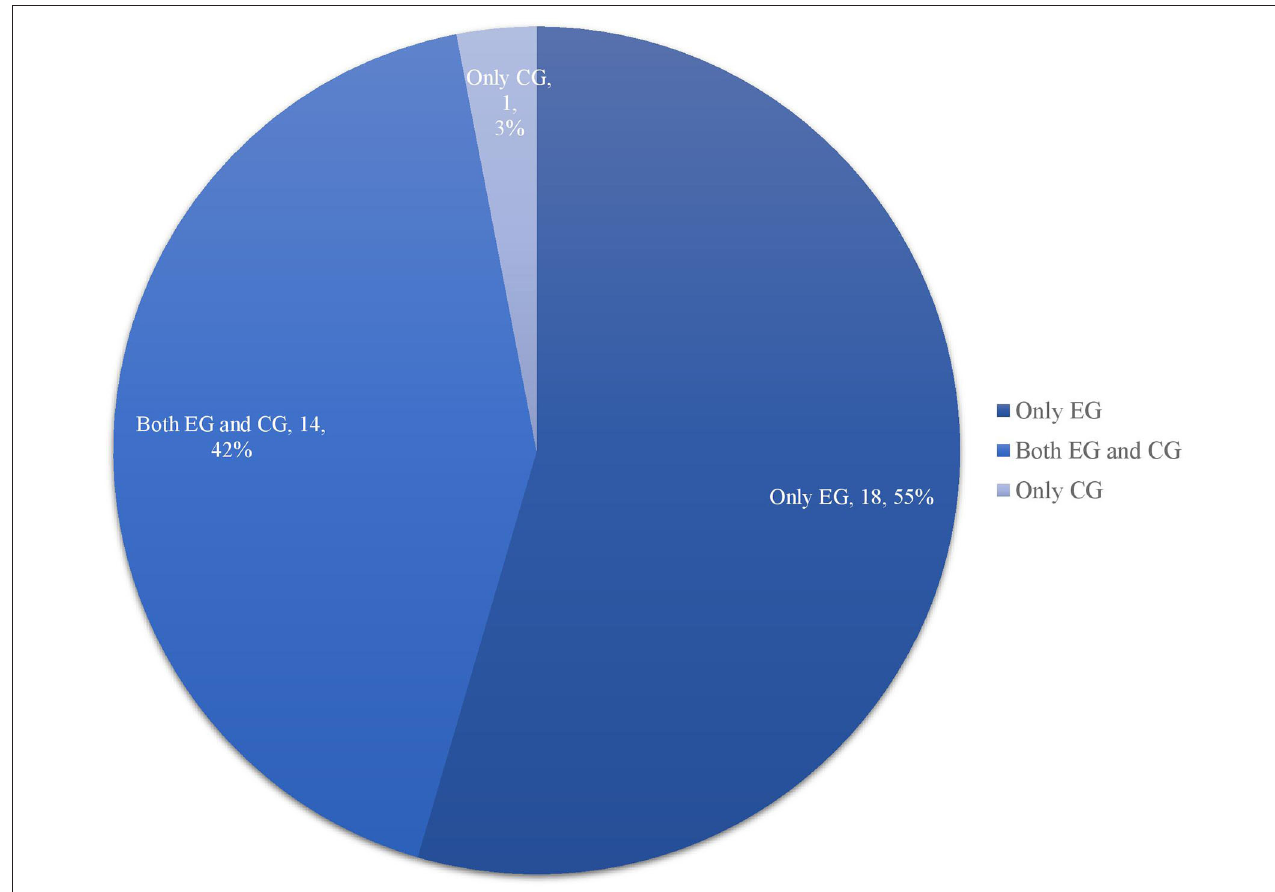
FIGURE 6 | Student participants involved in